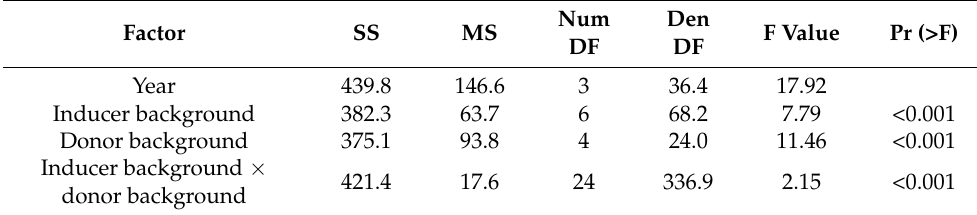
Table 1. The ANOVA table of fixed effects tested for the HIR.